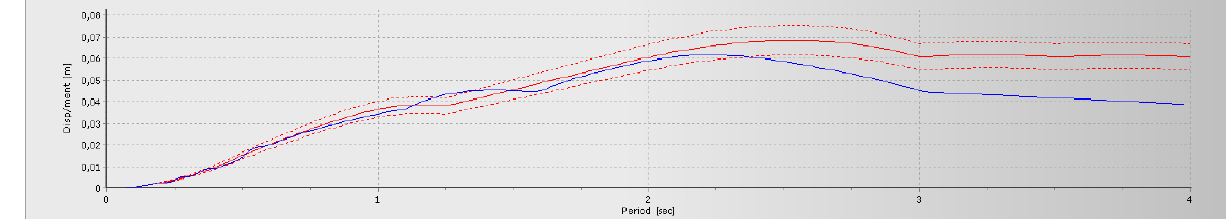
Figure 11. Comparison of the